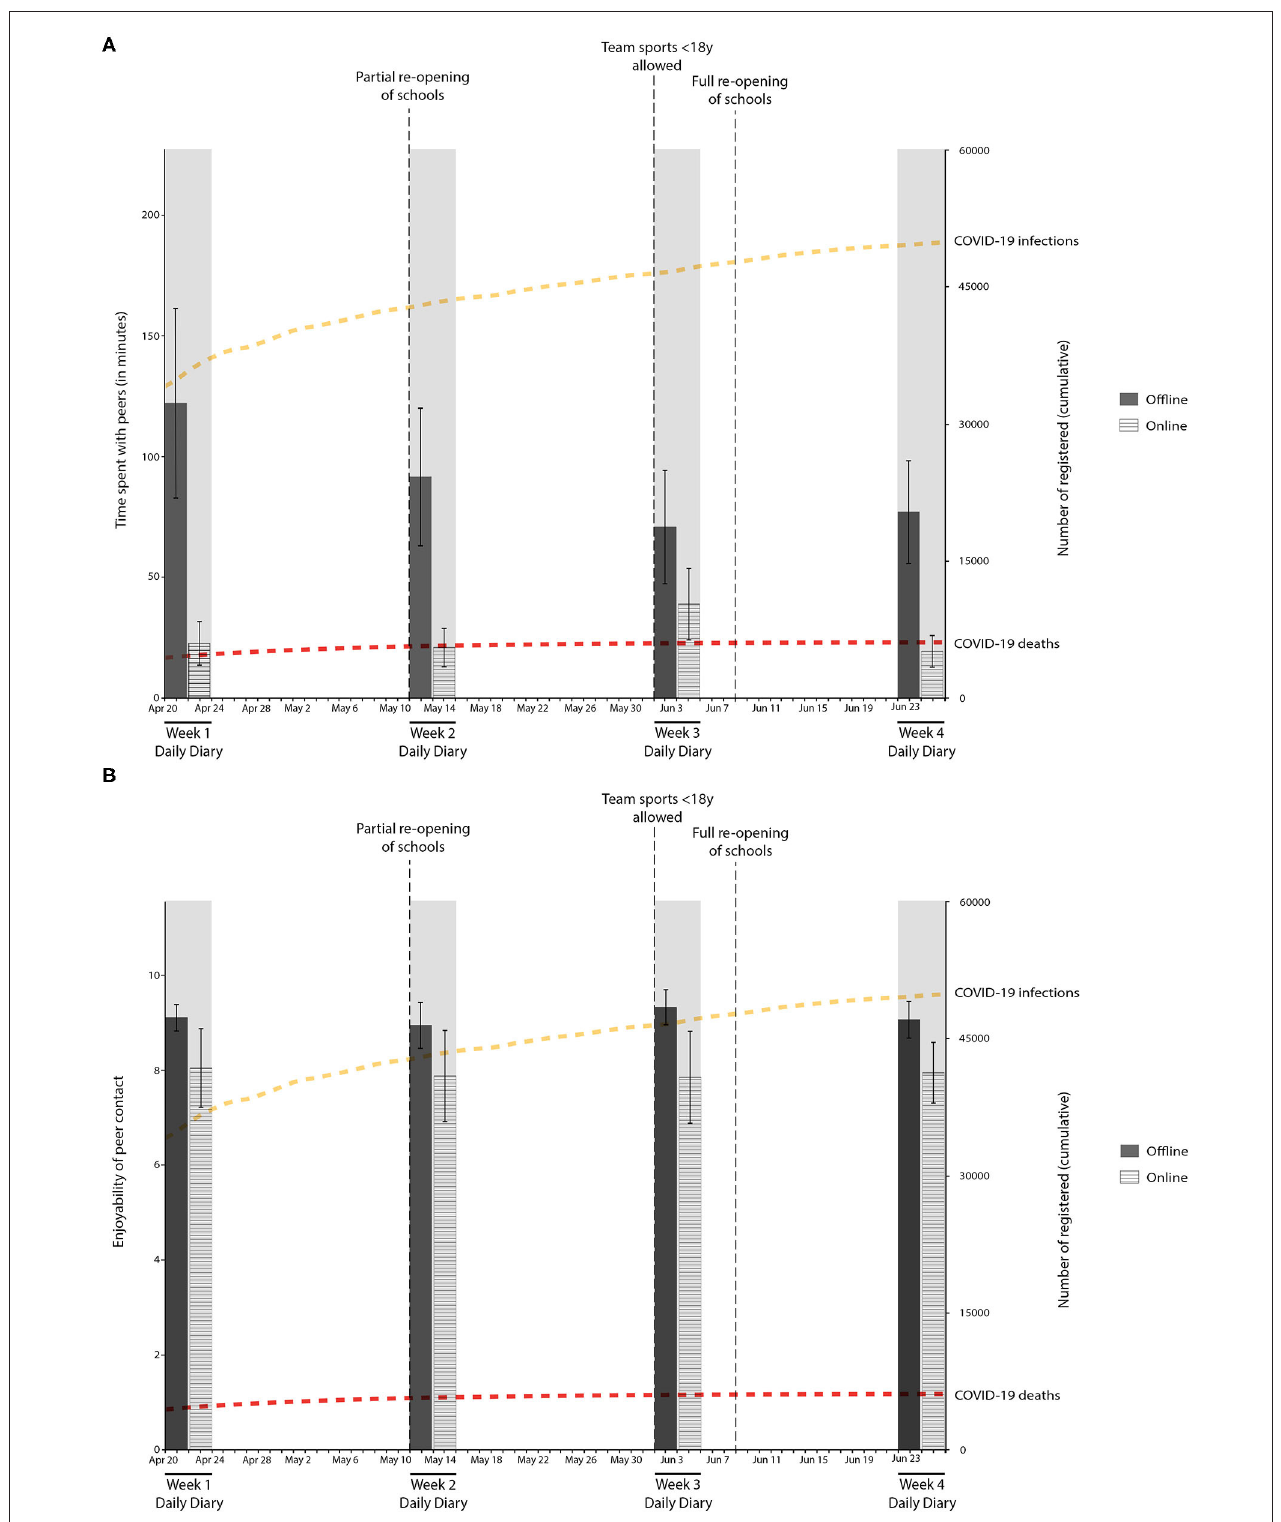
FIGURE 4 | Average time (A) and grade (B) of offline and online peer contact during the first few months of the COVID-19 pandemic.